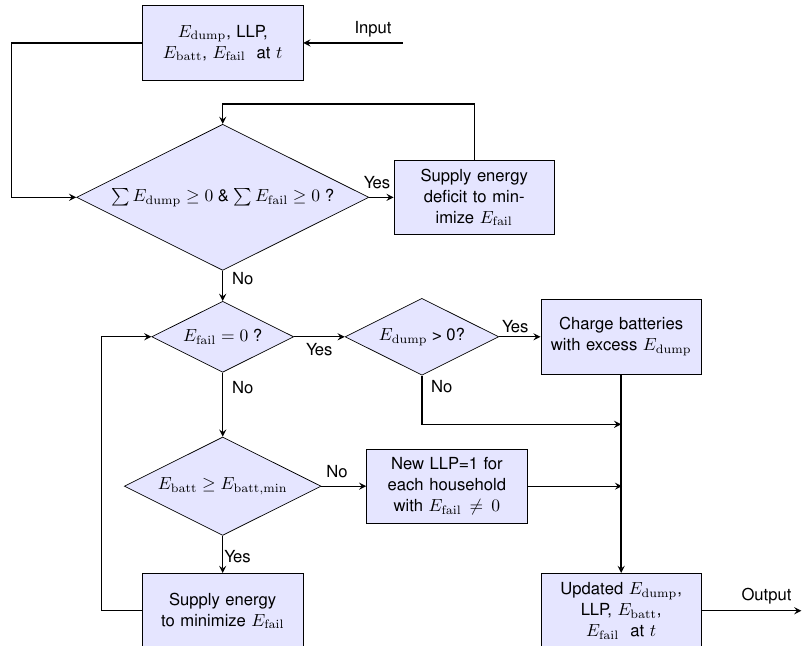
Figure 6. Algorithm for sharing the excess energy based on the ranking of load deficit (in terms of E fail and battery depth of discharge